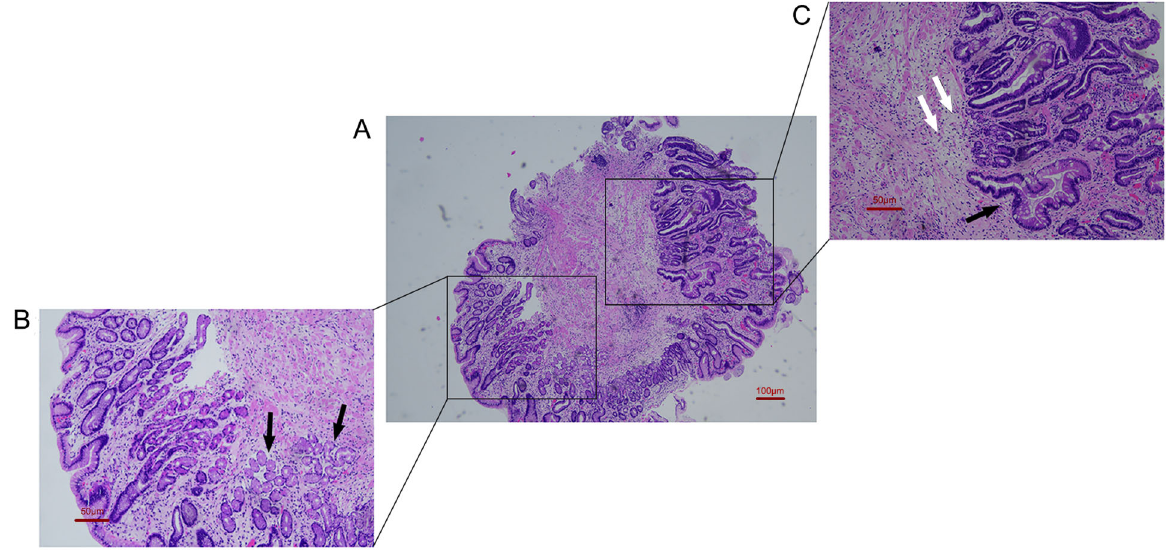
Figure 3. Pathological examination of a gastric antrum specimen in Case 1. A , Overall view ( (cid:1) 40, scale bar 100 m m). B , Local view ( (cid:1) 100, scale bar 50 m m) showing a small amount of normal antral glands (black arrows). C , Local view ( (cid:1) 100, scale bar 50 m m) showing that the normal glands in the submucosal basal layer are completely atrophied (white arrows) and replaced with numerous intestinal goblet cells and metaplastic glands (black